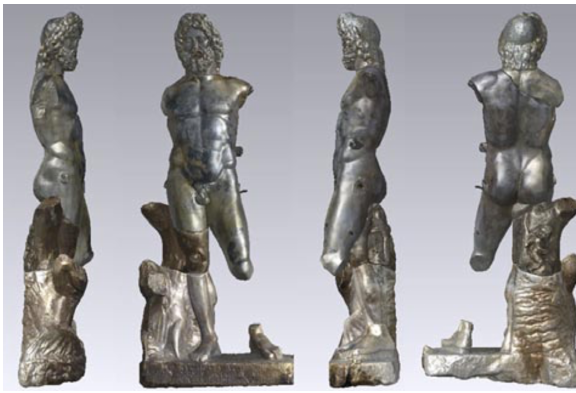
Figure 1. Picture of the Neptune statue (Coignard et al., 2009)